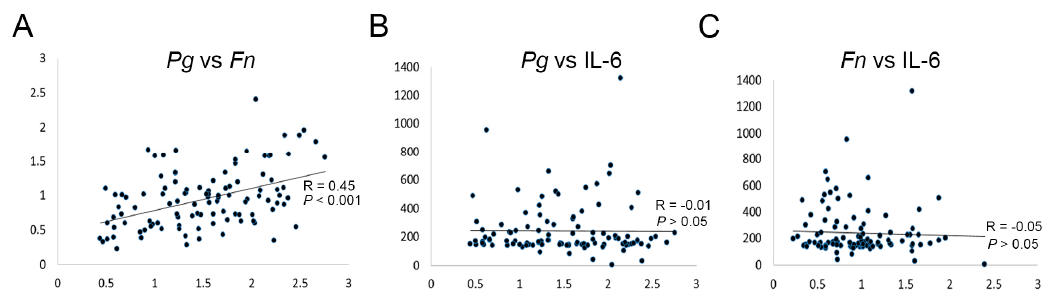
Figure 3. Correlation between serum IgG antibodies against P. gingivalis ( A , B ) and F. nucleatum ( A , C ) and IL-6 ( B , C ) in both OSCC patients and healthy controls.